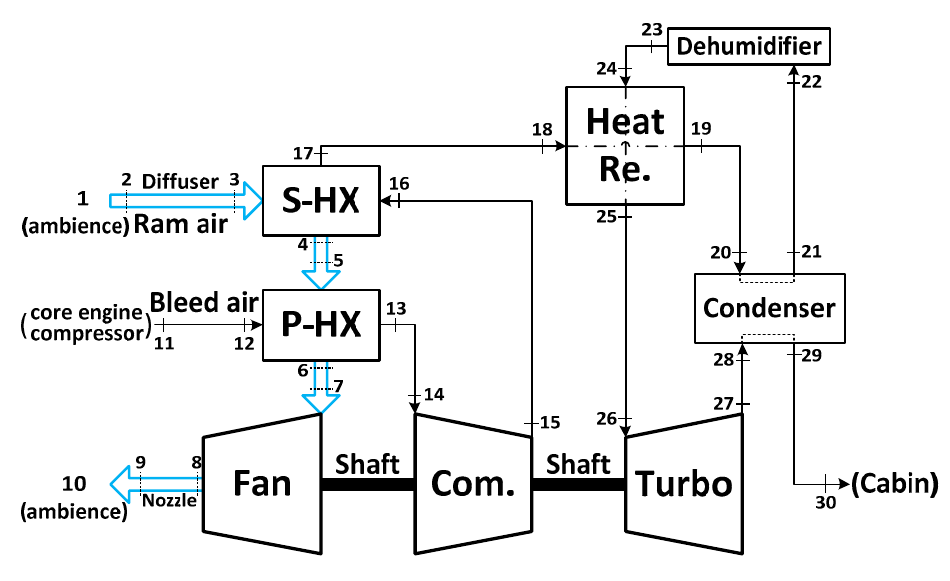
Figure 1. Schematic diagram of ECS.